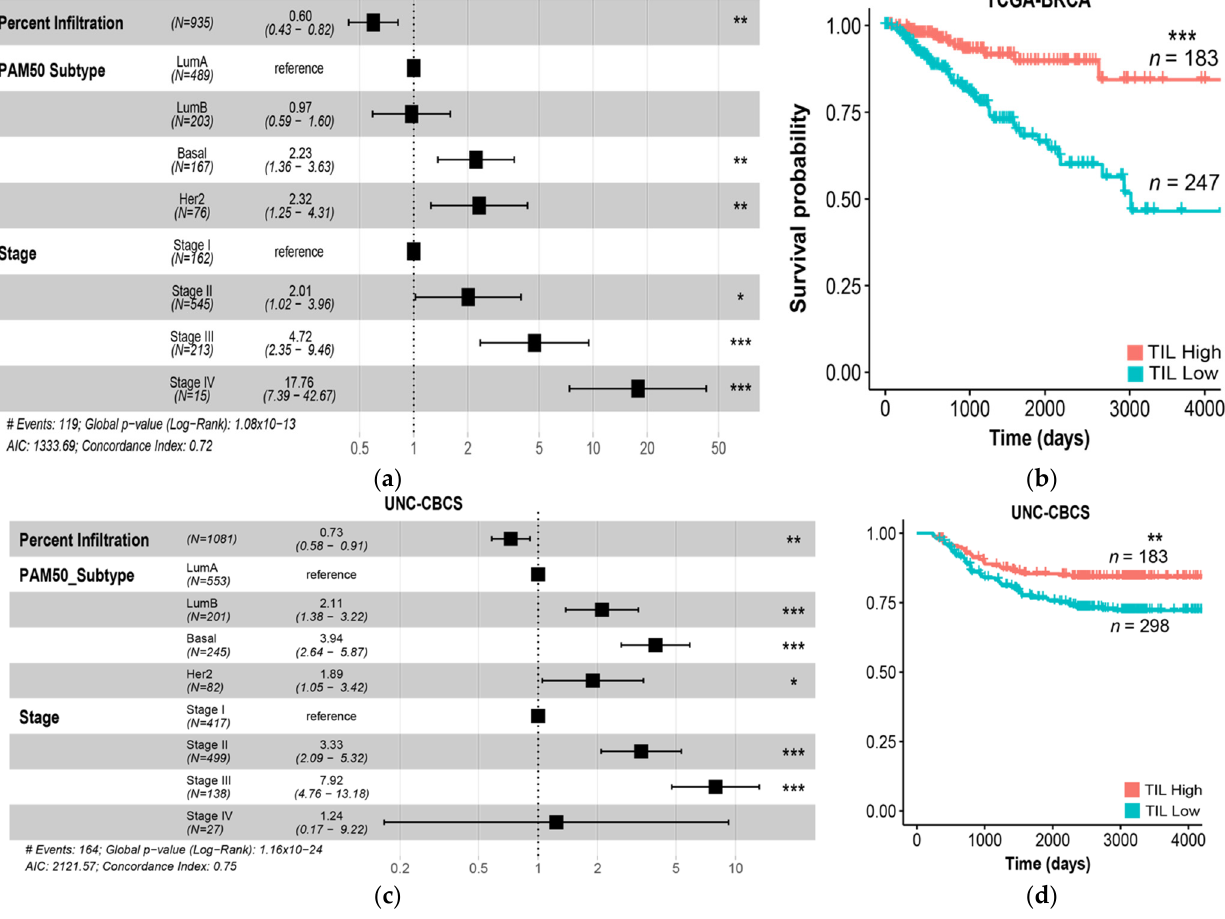
Figure 5. TIL infiltration remains strongly predictive of survival across TCGA BRCA and UNC CBCS. ( a ) Forest plots of hazard ratios (estimates and 95% CIs) from a multivariate Cox proportional hazards model of progression-free interval (PFI) incorporating PAM50 subtype and tumor stage. Vertical dotted line indicates a hazard ratio of 1. TIL infiltrate percentage ranges from 0% to 64.2% with SD of 10.4%. TIL infiltrate percentage is scaled by SD for all Cox Regression Analyses. ( b ) Kaplan–Meier survival analyses of TCGA BRCA patients after splitting into high and low TIL classes around the mean percent infiltration. ( c ) Forest plot of hazard ratios from a multivariate Cox proportional hazards model of PFI in the UNC CBCS including PAM50 subtype and tumor stage. TIL infiltration was calculated as a continuous variable with a range of 0% to 88.9% and scaled by SD (0.1), AIC: 2121.57. The dotted line indicates a hazard ratio of 1. The Concordance Index shows how much variance of risk is explained by the model, where 1 encapsulates all risk whereas 0.5 is random. ( d ) Kaplan–Meier survival analyses after dividing UNC CBCS patients into high and low TIL infiltration groups around the mean TIL infiltrate percentage. *** = p < 0.001, ** = p < 0.05, * = p <